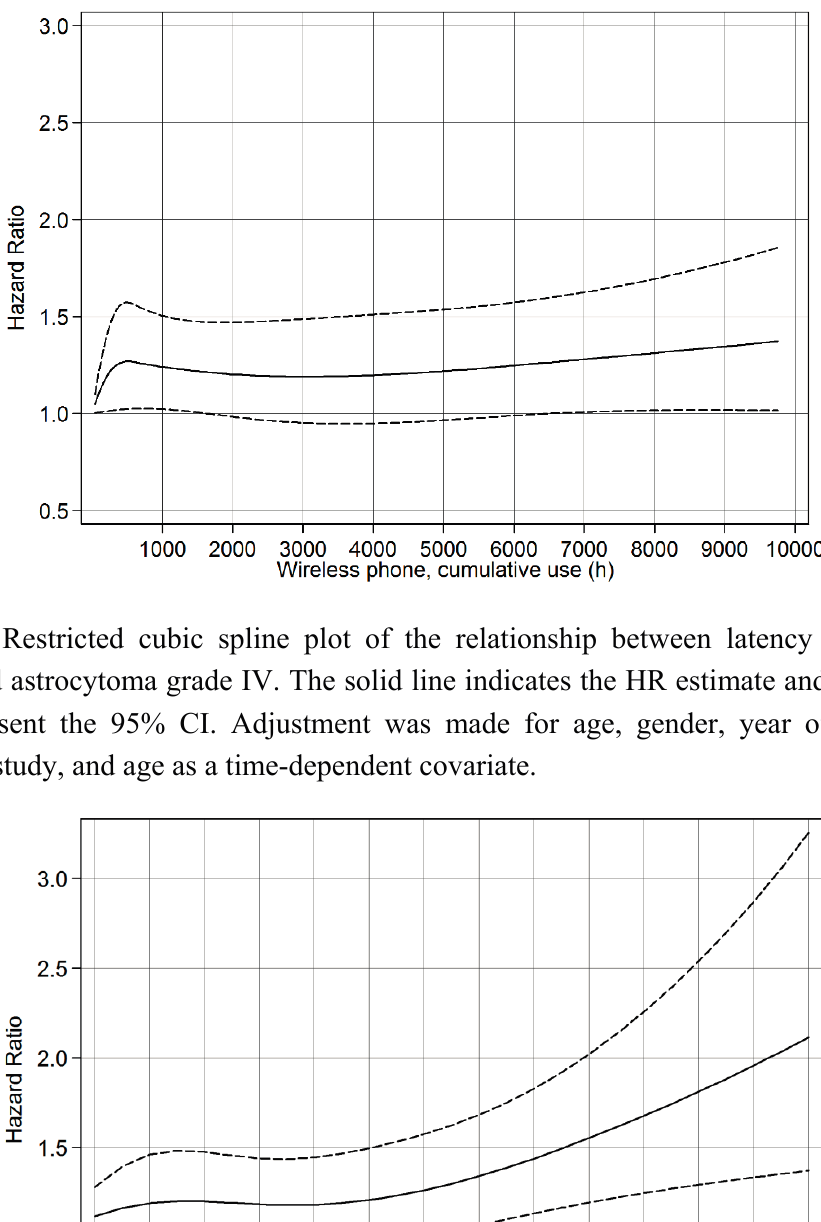
Figure 1. Restricted cubic spline plot of the relationship between cumulative use of wireless phones and astrocytoma grade IV. The solid line indicates the HR estimate and the broken lines represent the 95% CI. Adjustment was made for age, gender, year of diagnosis, SEI-code, study, and age as a time-dependent covariate.